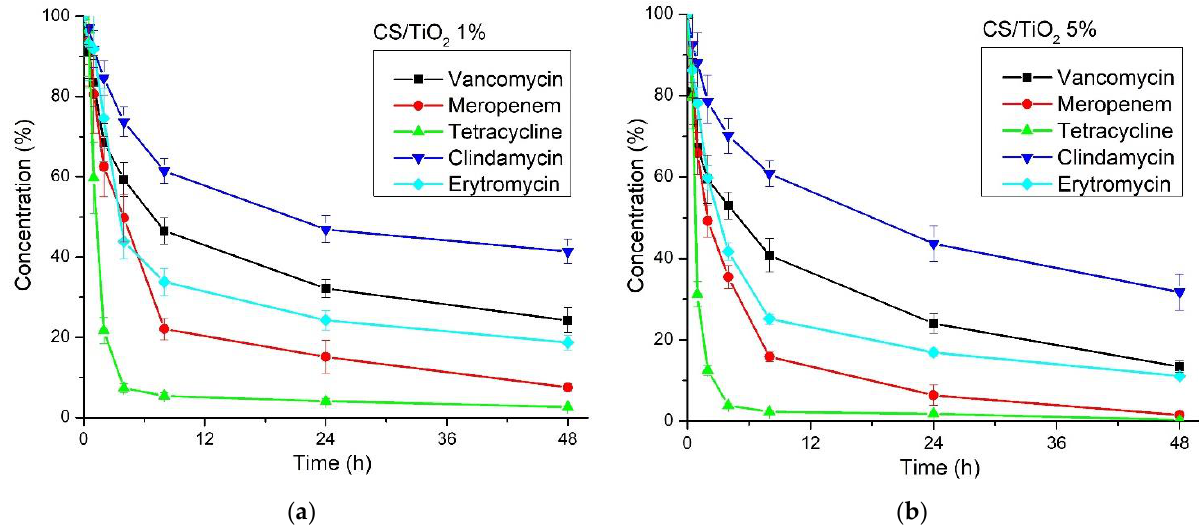
Figure 13. The percentile concentration of each antibiotic after irradiation in the presence of ( a ) CS/TiO 2 1% and ( b ) CS/TiO 2 5% membranes. The removal efficiency values, calculated as the percent of initial antibiotic concentra- tion removed during 48 h of irradiation, are presented in Table 5. Antibiotic removal efficiency (%) of chitosan/TiO 2 composite membranes at 48 h.